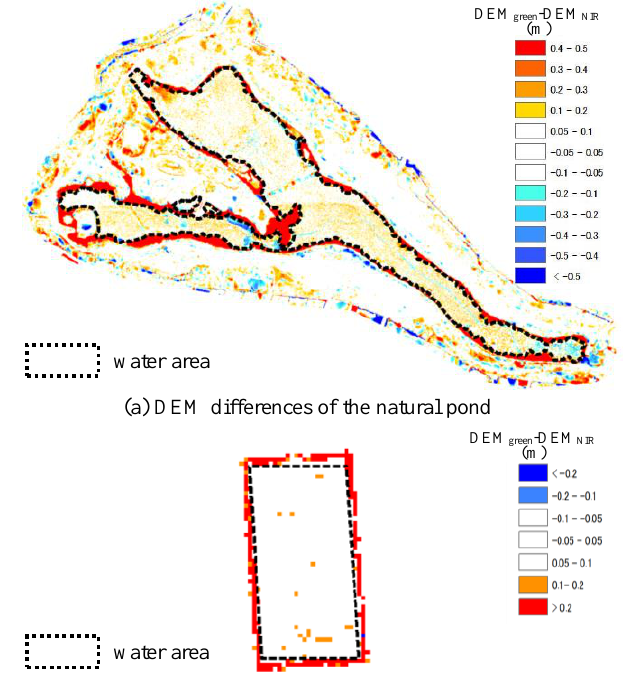
Figure 6. Colour shaded relief map of the artificial pool